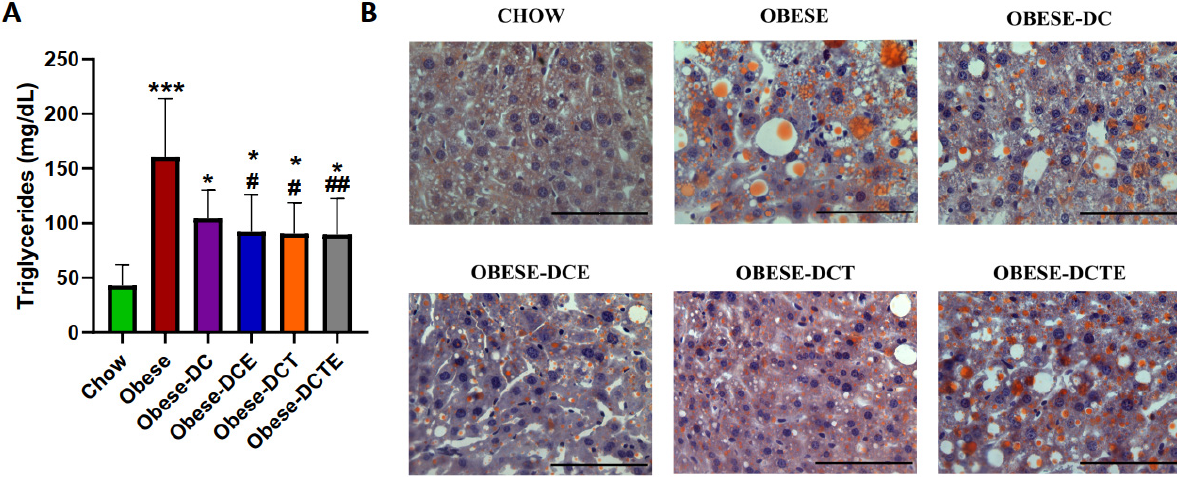
Figure 3. Quantification of triglycerides in the liver ( A ) and representative images of liver sections Scheme 100 M ( B ). Chow = mice fed a standard diet for 25 weeks; Obese = mice fed a high fat (60% kcal from fat)/high sucrose diet for 25 weeks; DC = mice fed a high fat (60% kcal from fat)/high